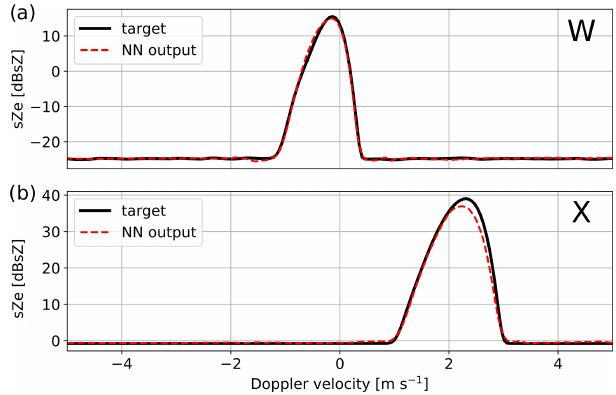
Figure 3. Examples of results of the synthetic testing set of the decoders, showing the decoder output (dashed red) and the tar- get PAMTRA-generated spectrum (black line) at the (a) W band and (b) X band. The examples were chosen to reflect some of the typical behaviors and possible artifacts that were observed; the X- and W-band examples do not correspond to the same micro- physical properties. Units of spectral reflectivity are used, defined as 1dBsZ = 10log 10 (1mm 6 m − 3 (ms − 1 ) − 1 ). Doppler velocity is positive for downward